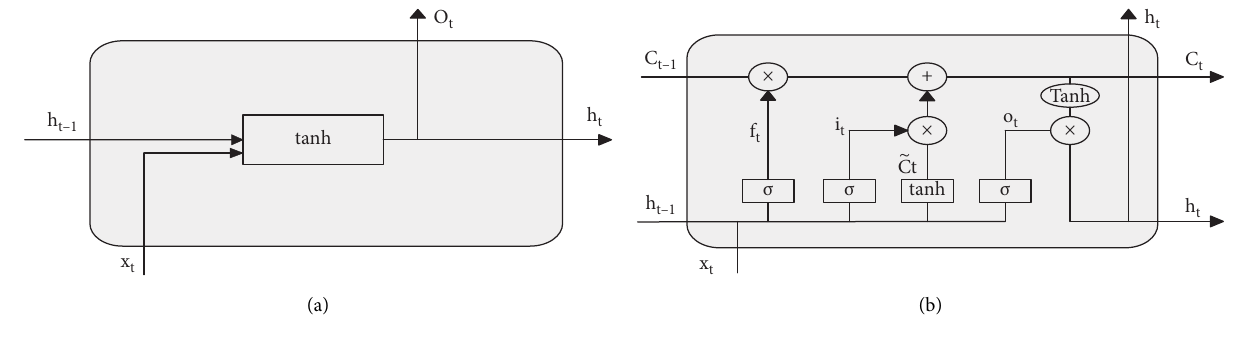
Figure 4: The loop cell structure of (a) RNN and (b)